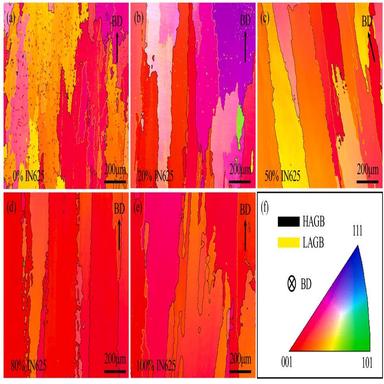
Inverse pole figure (IPF) maps of the FGM from 100 wt% SS308L (a) to 100 wt% IN625 (e), including grain boundary orientation, (f) IPF scale illustration and direction statement (BD: building direction).